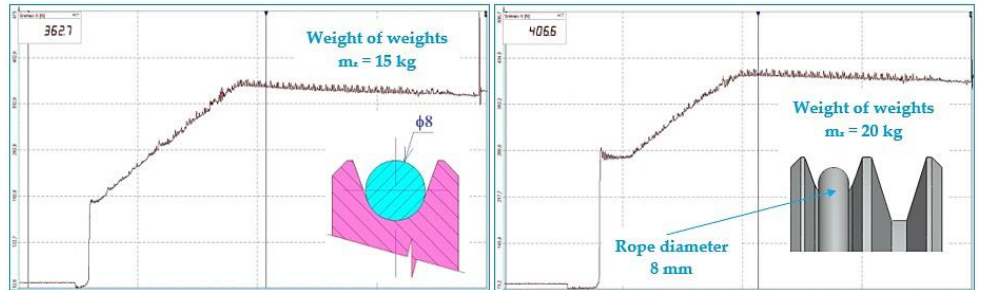
Figure 12. Pulling force F N on the cable on the advancing side of the pulley of the laboratory de-